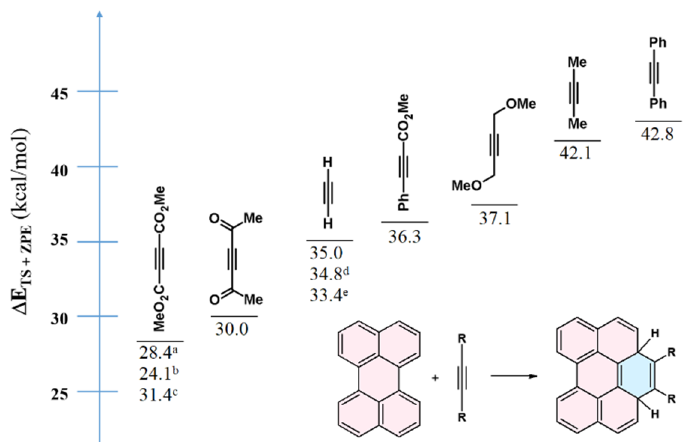
Figure 6. Calculated energy barriers for transition states ( ∆ E TS ) in modeled cycloaddition reactions of R-CC-R to perylene and tetraamino- and tetranitro perylene bay regions, obtained by the DFT / B3LYP / def2-TZVP method [152]. Results with superscripts a, b, and c correspond to the cycloaddition of acetylenedicarboxylic acid to perylene, tetraaminoperylene, and tetranitroperylene, respectively. Superscripts d and e relate to energy barriers for the reaction of acetylene with tetraaminoperylene and tetranitroperylene.